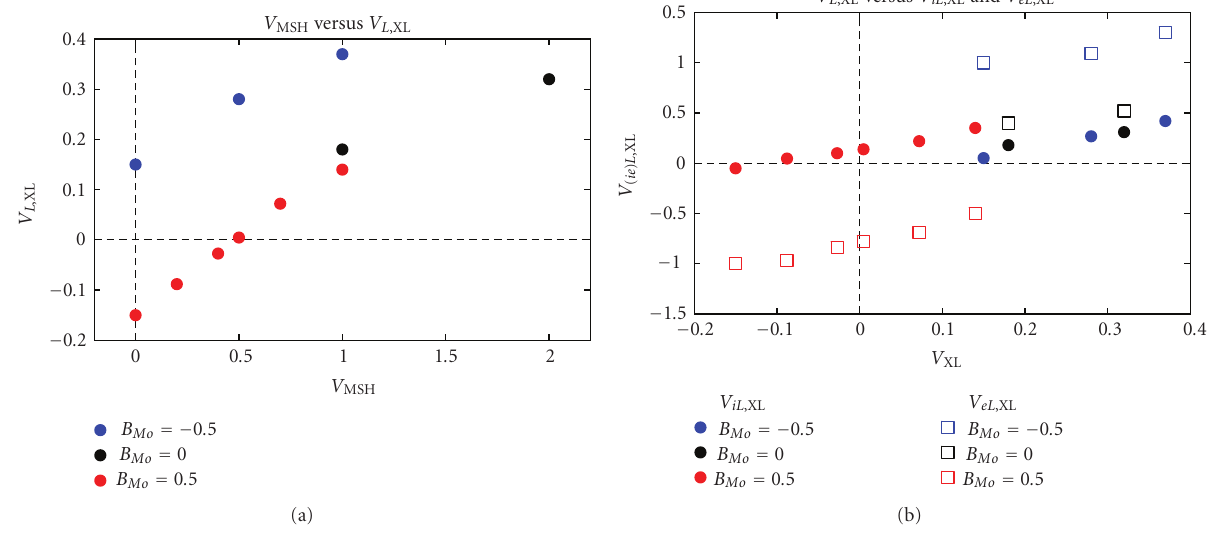
Figure 17: The summary plot for the discussion on the X-line motion. Di ff erent color indicates di ff erent B Mo cases (blue, black, and red for B Mo = − 0 . 5, 0, and 0.5). (a) V L ,XL versus V MSH . While V L ,XL is larger for larger V MSH in general, the X-line motion can be opposite to the magnetosheath flow when V MSH is small and B Mo = +0 . 5. (b) Comparison of V L ,XL with V iL,XL (solid circles) and with V eL,XL (open squares). The interpretation is that the electron e ff ects set in with the nonzero guide field and can dominate to determine the direction of the X-line motion when the shear flow e ff ects are small.